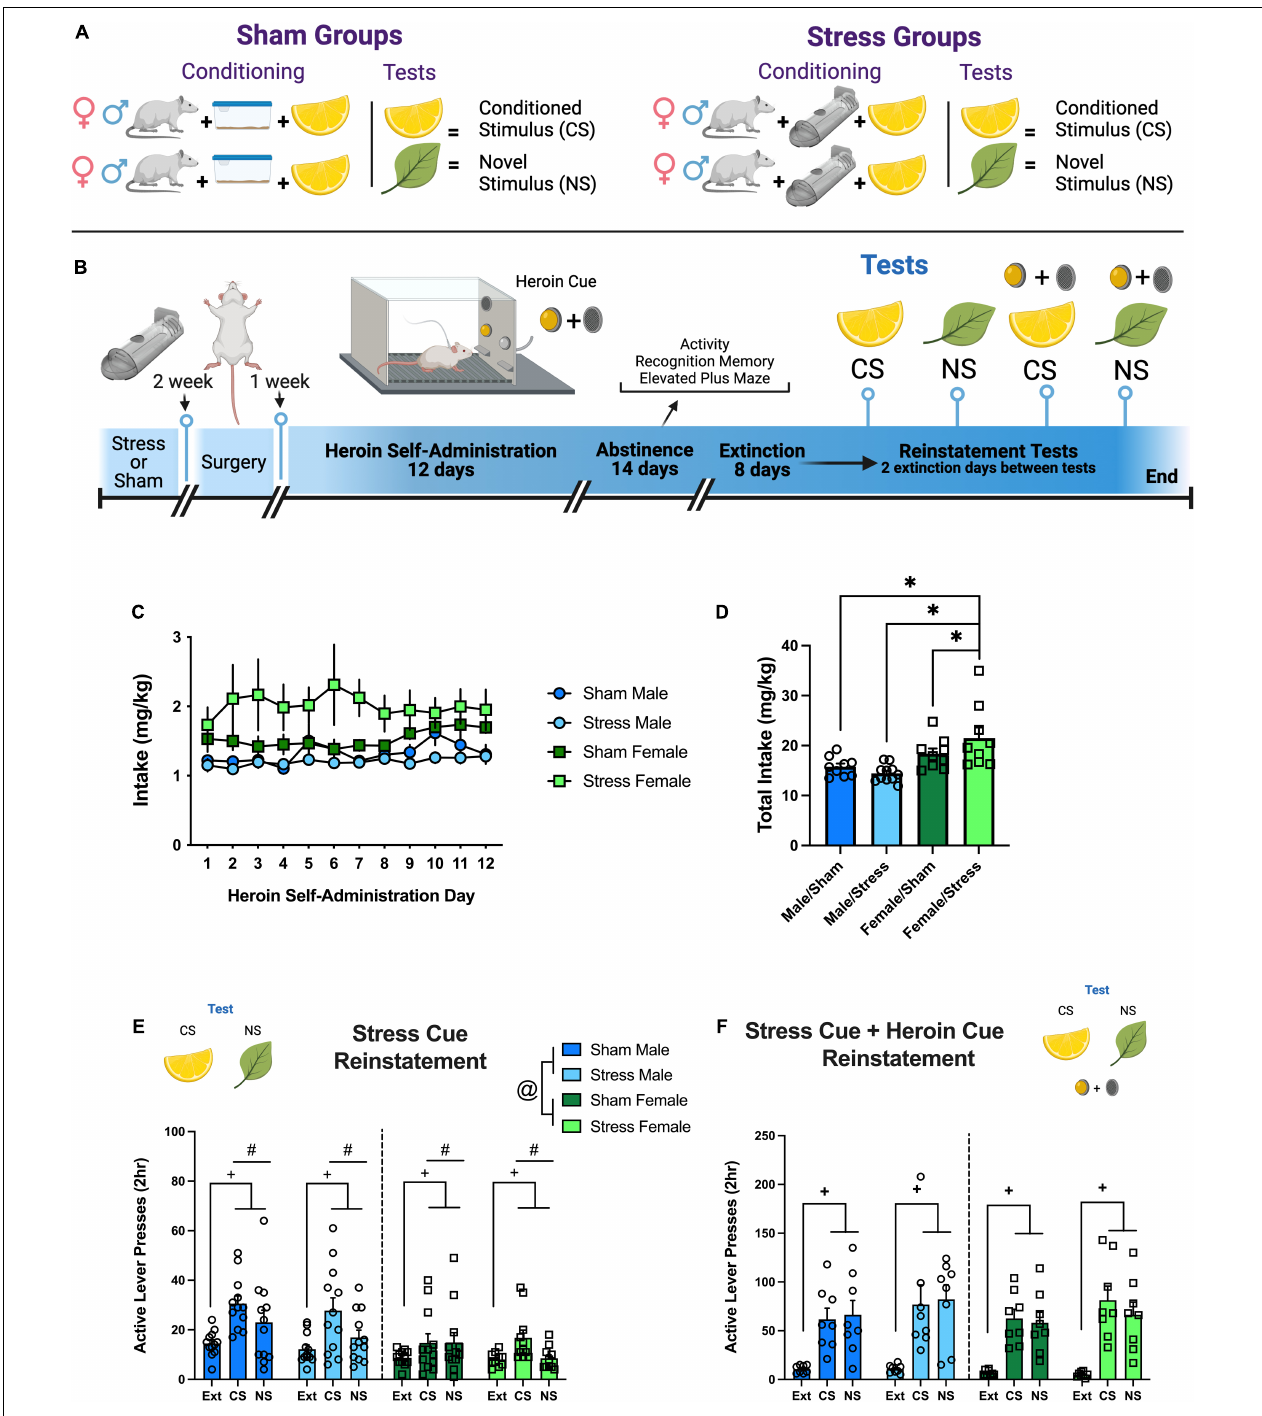
FIGURE 1 | Experiment 1: sex and stress impacts reinstated heroin seeking in response to a stress conditioned stimulus and a novel stimulus. (A) Visual depiction of sham/stress groups and their relationship with the odor stimuli. (B) Experiment 1 timeline. (C) Heroin intake adjusted for body weight (mg/kg) over 12 self-administration sessions. (D) Total heroin intake (mg/kg) over all 12 days. Stress females took more heroin than sham females, stress males, and sham males. (E) Active lever responding during stress Cue reinstatement tests. Males responded more than females over the test sessions. All rats increased responding to the stress CS and NS relative to extinction and discriminated between the CS and the NS. (F) Active lever presses during stress Cue + heroin cue test. All rats reinstated responding to the CS and NS. Data are represented as group means ± SEM with individual values. * indicates significant difference from stress females, p < 0.05. # indicates significant difference from CS detected by a main effect of test, p < 0.05. + indicates significant difference from extinction detected by a main effect of test, p < 0.05. @ indicates main effect of sex, p < 0.05.